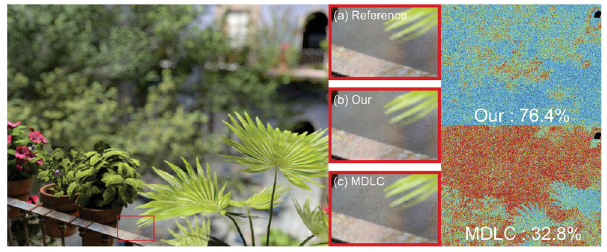
Fig. 4 San Miguel scene with DOF.